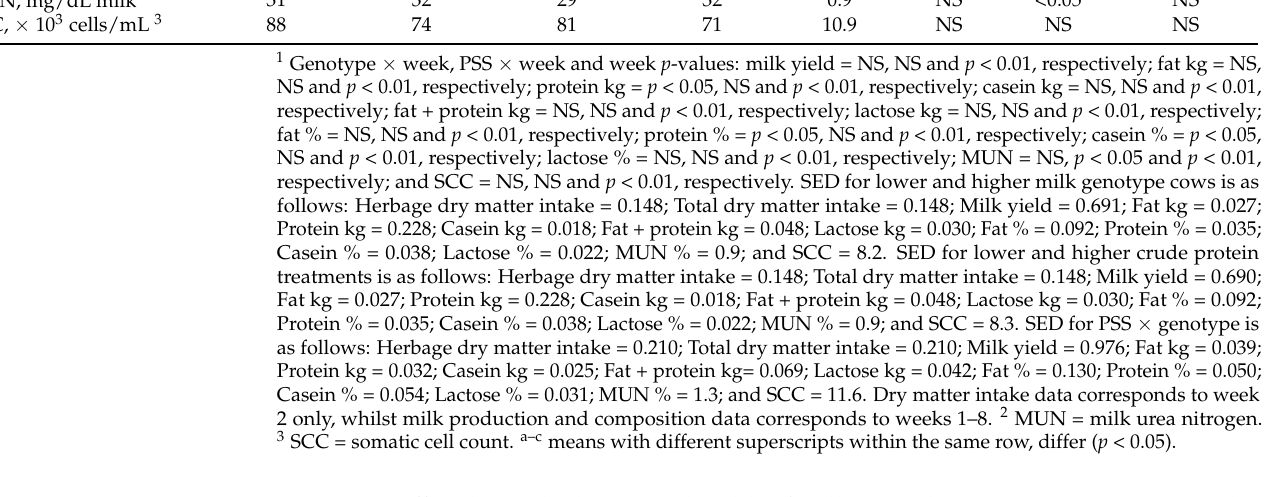
Figure 4. Effect of protein supplementation strategy × week on milk protein yield [asterisks (*) indi- cate a significant difference for week].